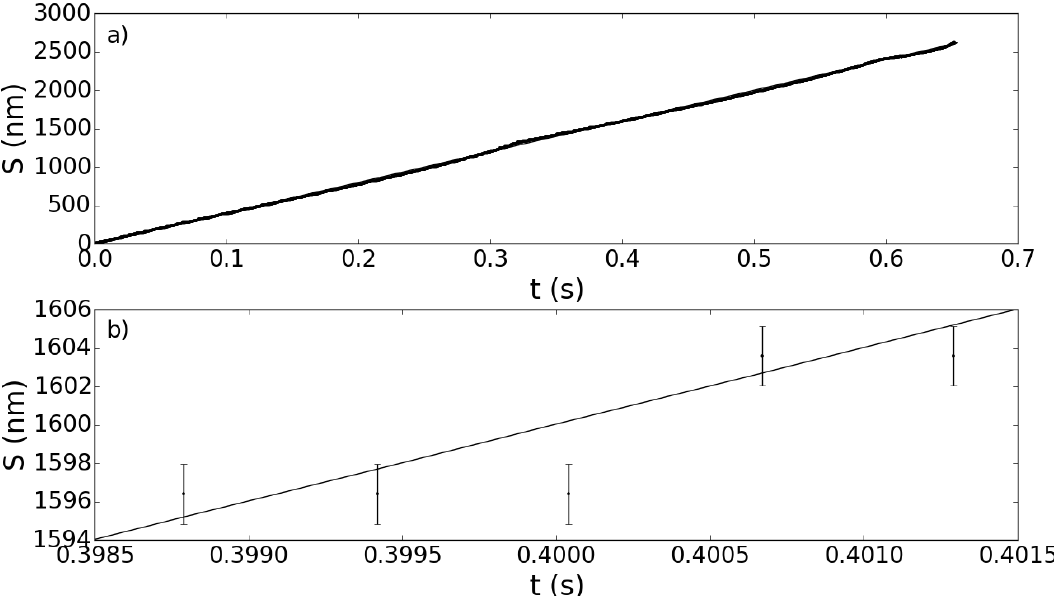
Figure 5. Plot of the position of the object target (OT) target S ( t ) versus time, for a = 5 × 10 − 3 m/s and v = 4 × 10 − 6 m/s. The other parameters are simulation with v r o as in Figure 3. The solid line represents the theoretical position S (see Equation (5)). th The dots mark the position S as predicted by the phenomenological Equation (7) and phen the associated errors σ as given by Equation (11). ( a ) The representation over the entire S period of a slow fringe; ( b ) a close-up in which the accuracy of S in retrieving S phen th can be